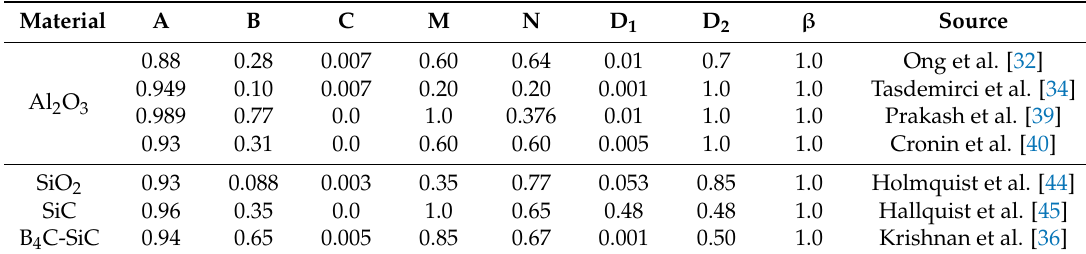
Table 1. Properties found in the